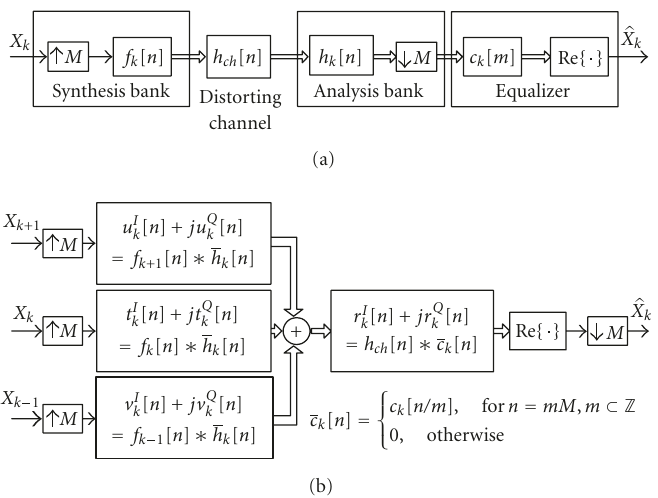
Figure 2: Complex TMUX with per-subcarrier equalizer. (a) System model for subchannel k . (b) Equivalent form including also contiguous subchannels for crosstalk analysis.